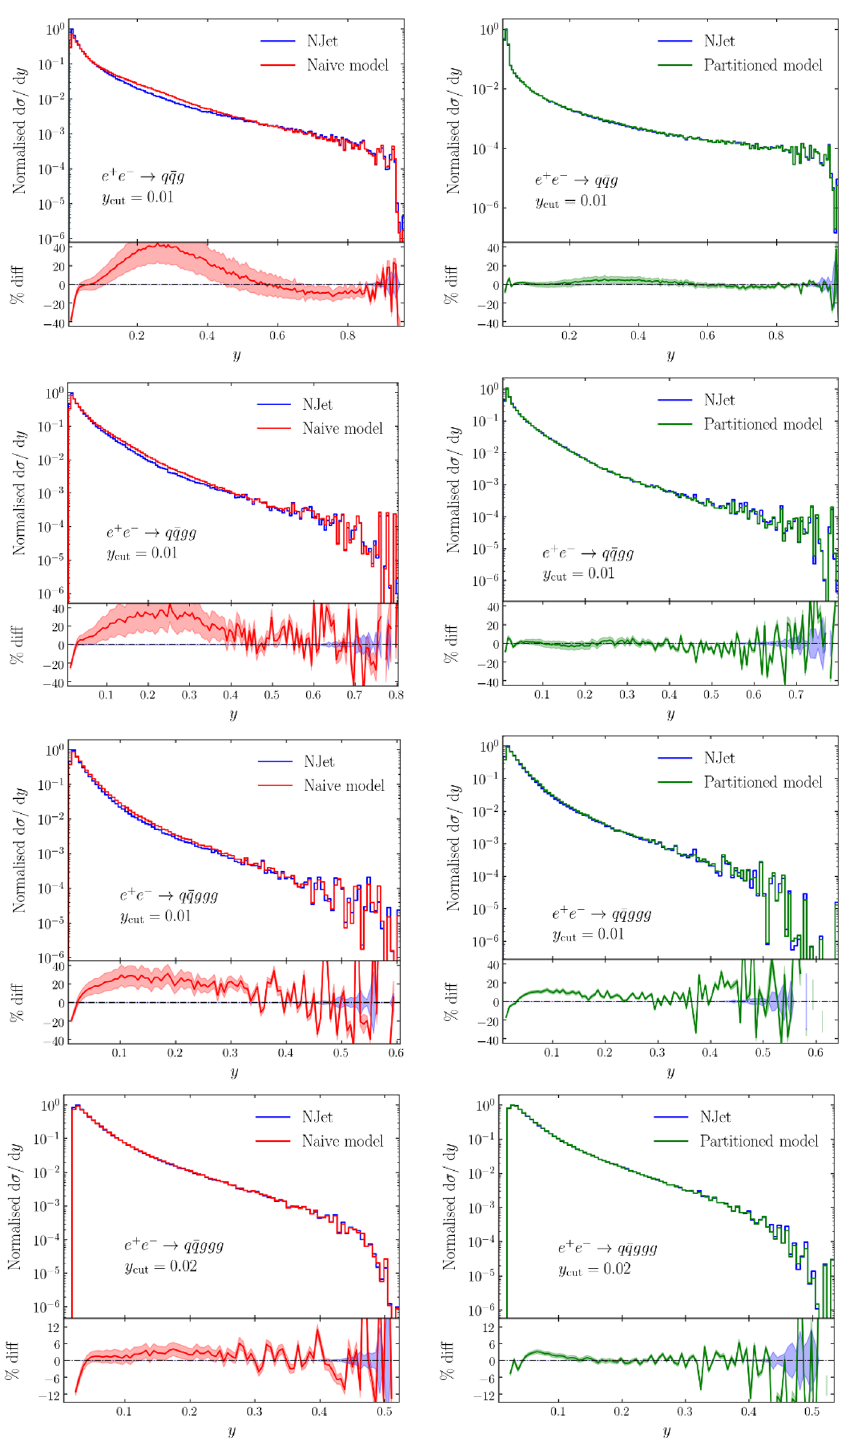
Figure 5 . Comparison of the naive approach (left) vs. the partitioned approach (right) in estimating the di(cid:11)erential cross-section against y , where y is the minimum y ij as ordered by p T . Data is normalised to the maximum Njet bin value. Uncertainty bands as described in (cid:12)gure 4.